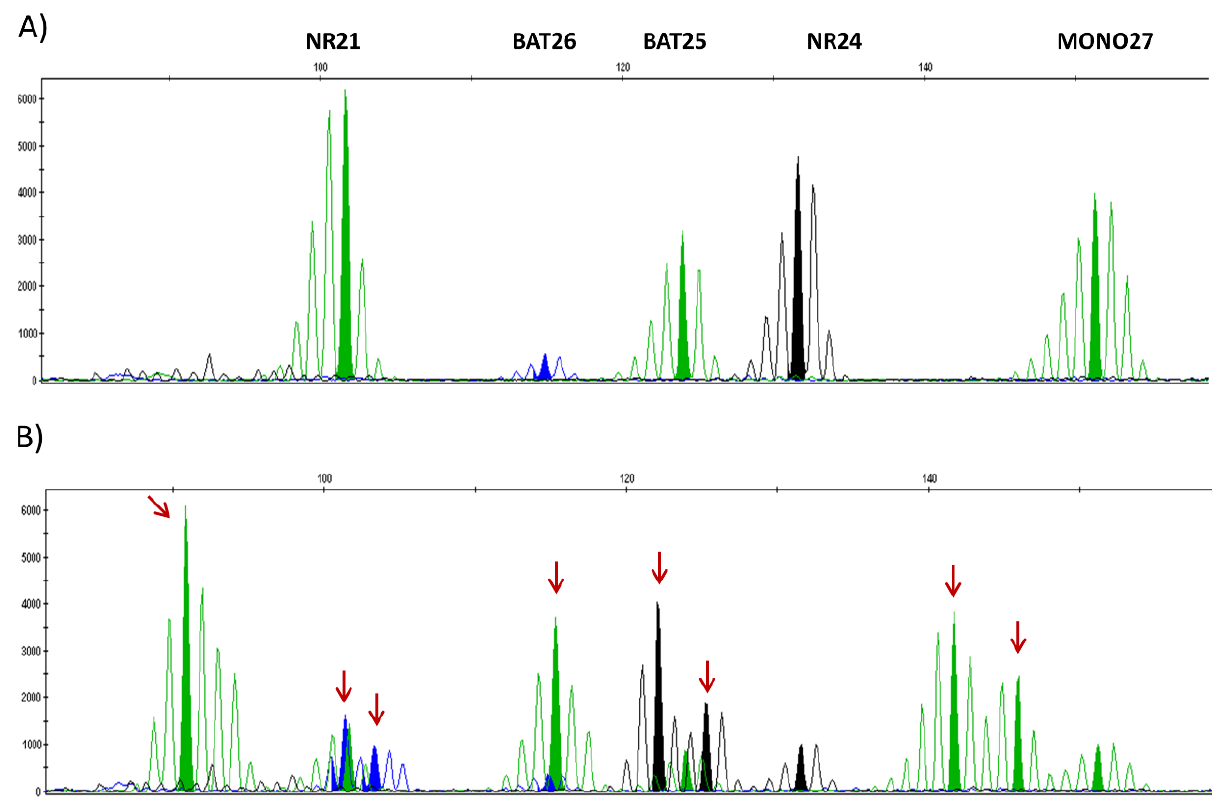
Figure 2. MSS/MSI profiles using the pentaplex panel [10]. Legend: ( A ): MSS profile of the five-consensus mononucleotide repeats. ( B ): MSI profile with five unstable mononucleotide repeats. Red arrows indicate unstable microsatellites.